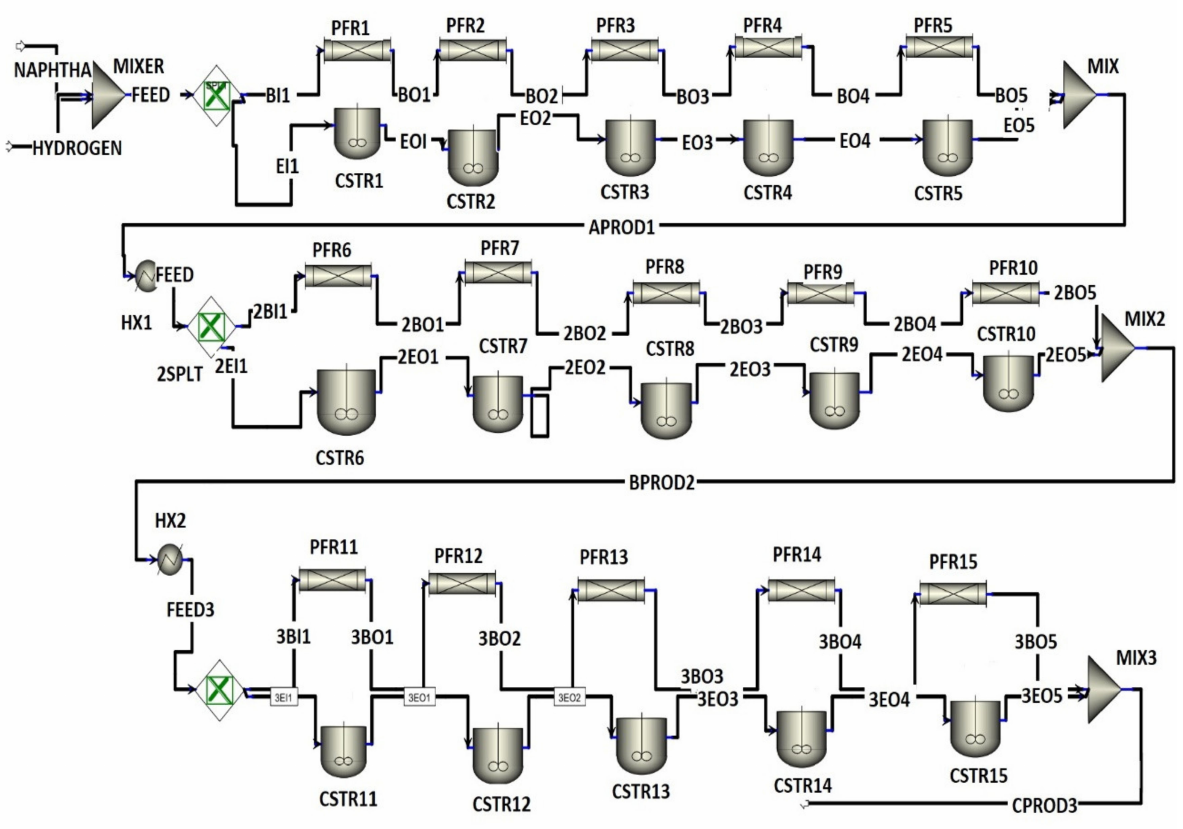
Figure 7. Process flow diagram of FBR.